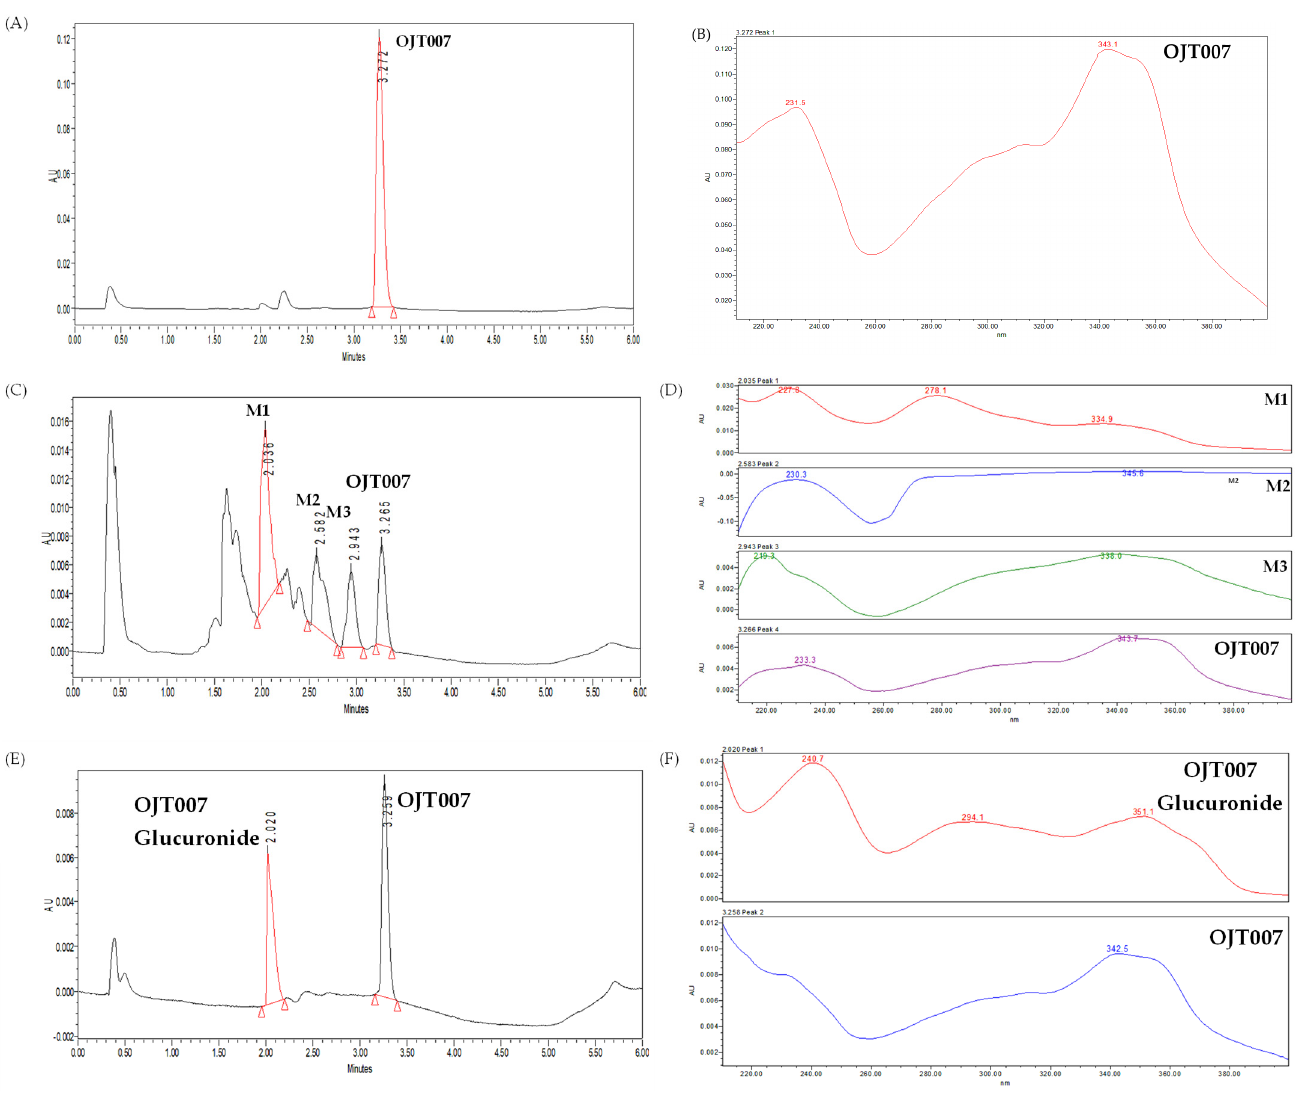
Figure 2. ( A ) Representative chromatogram and ( B ) UV Spectra of OJT007 before microsomal incubation OJT007. ( C ) Representative chromatogram and ( D ) UV spectra of OJT007 and oxidation metabolites after microsomal incubation. ( E ) Representative chromatogram of OJT007 and glucuronidation metabolite. ( F ) UV spectra of OJT007 and glucuronide metabolite. Phase I Metabolites Identification by LC-MS/MS